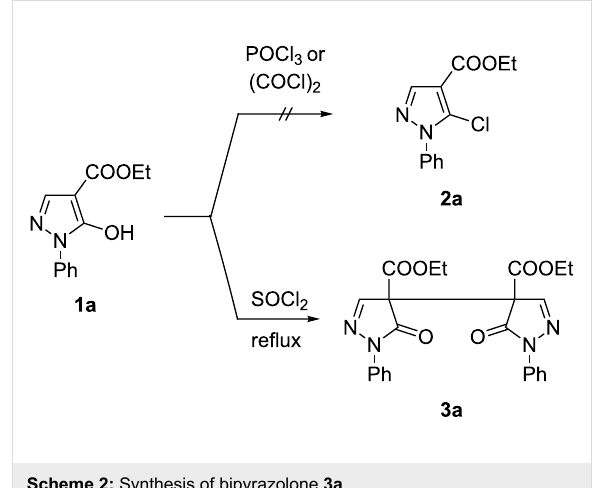
Scheme 2: Synthesis of bipyrazolone 3a .